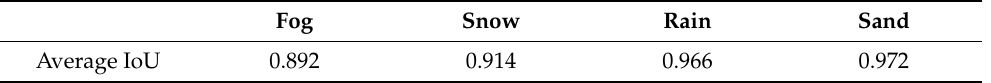
Table 4. Average IoU values calculated by taking 10 random images from each weather condition.